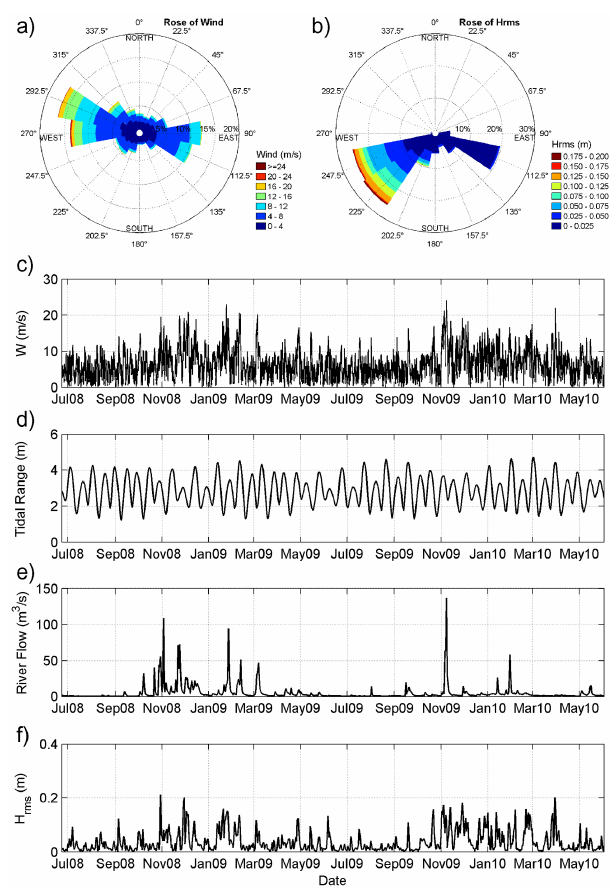
Figure 9. (a) Wind rose. (b) Wave rose. (c–f) Time series of the (c) wind speed W , and the daily averaged (d) tidal range, (e) river flow rate and (f) root-mean-squared wave height of the wind waves H rms